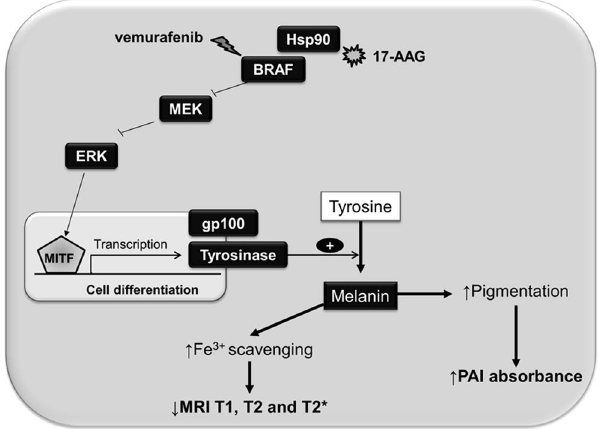
Figure 1. Schematic representation of the molecular basis for the induction in melanin and generation of MRI and PAI-based contrast following exposure of BRAF mutant human melanoma cells to BRAF and Hsp90